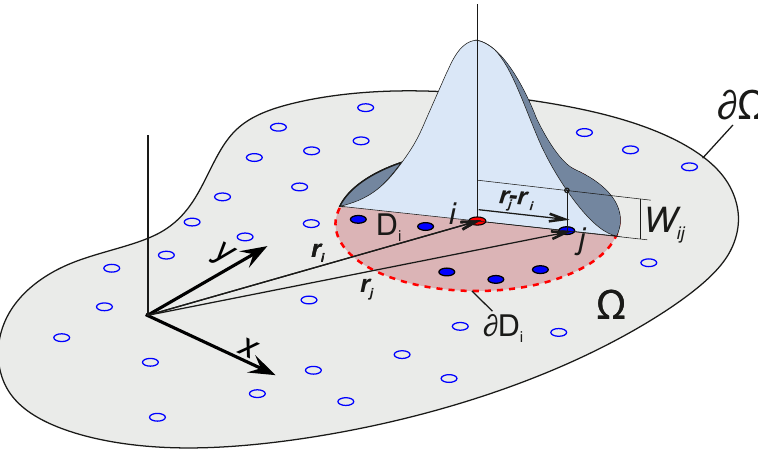
Figure 1. Computational domain Ω and kernel support D i of particle i